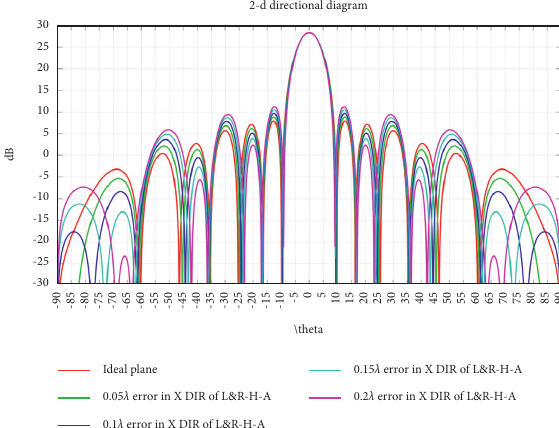
Figure 9: The change of the azimuth pattern caused by the position error of the left and right half arrays in the X